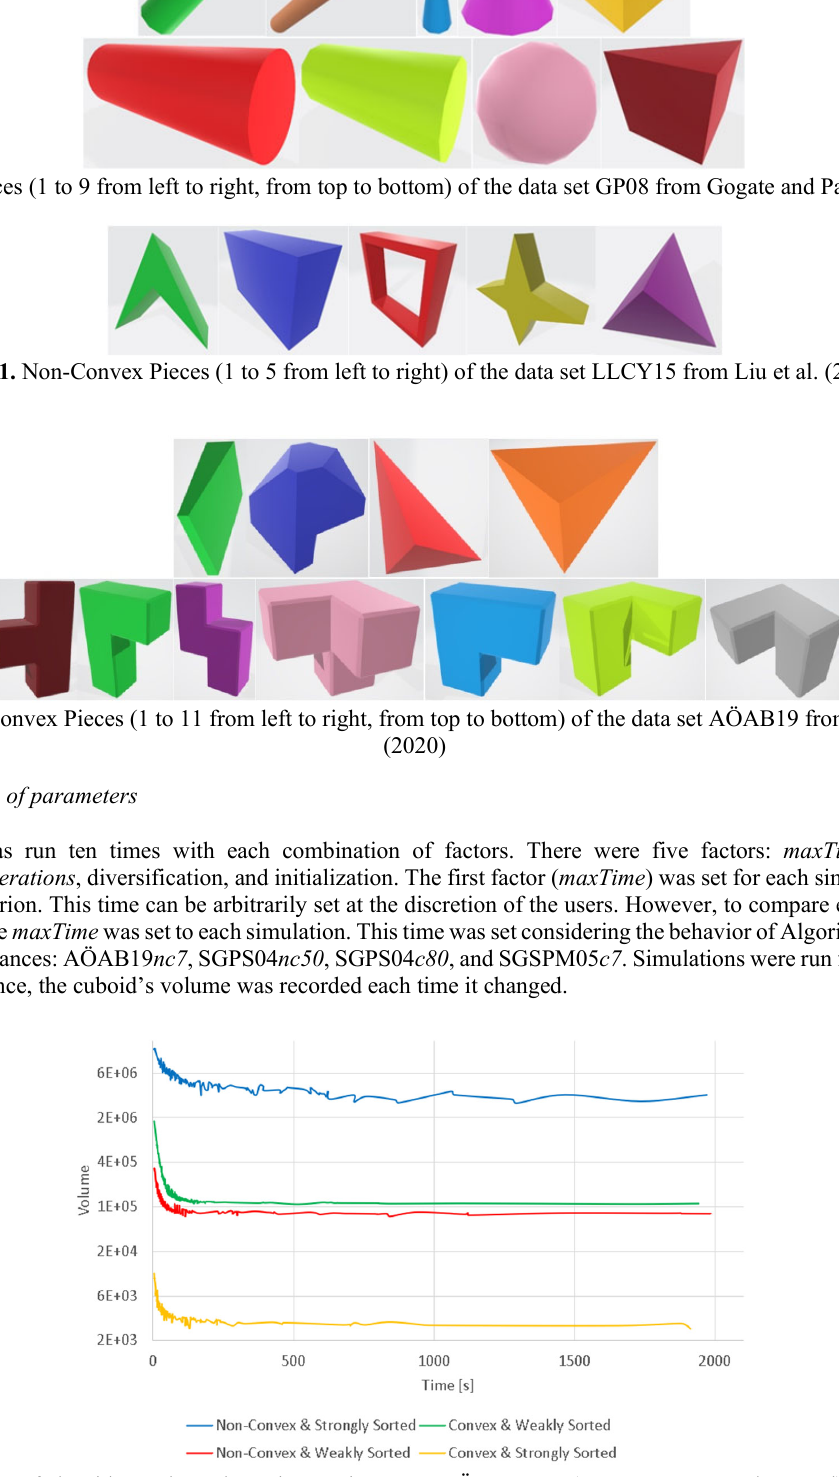
Fig. 13. Behavior of algorithm 2 throughout time on instances AÖAB19nc7 (non-convex strongly sorted), SGPS04nc50 (non-convex weakly sorted), SGPS04c80 (convex weakly sorted), and SGSPM05c7 (convex strongly